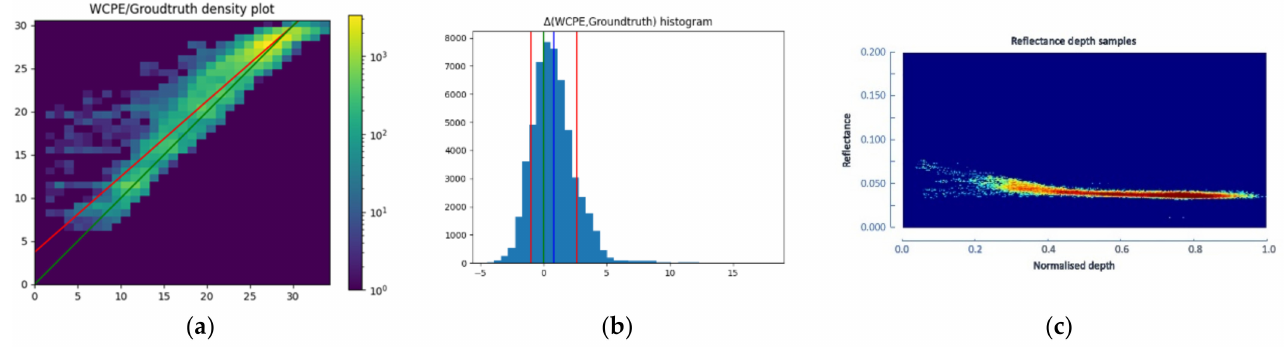
Figure 28. WorldView statistical analysis. ( a ) WV/Groundtruth scatter plot; ( b ) WorldView histogram; ( c ) WV density